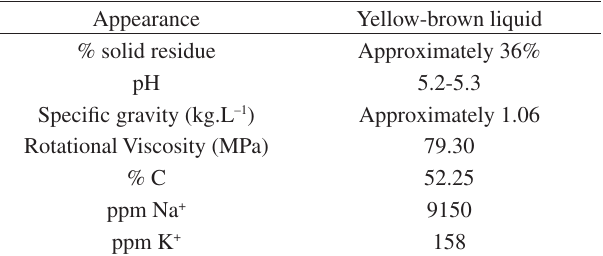
Table 3. Physical and chemical characteristics of the polycarboxylate admixture.